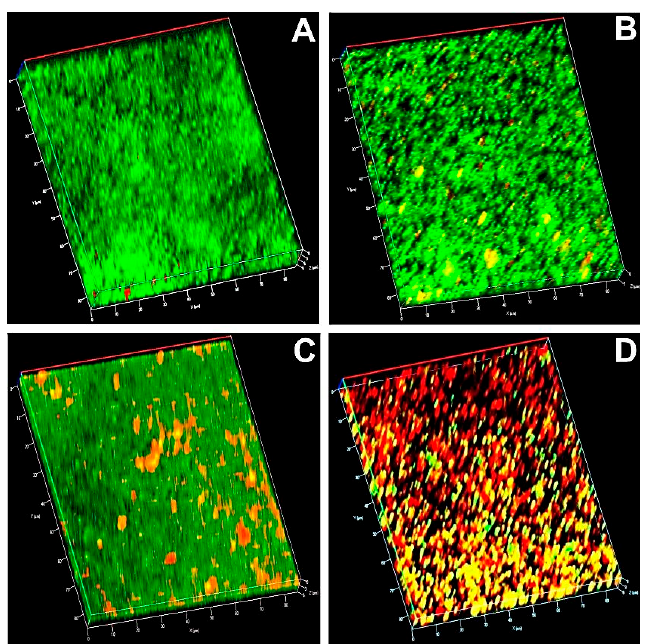
Figure 6. Confocal laser scanning microscopic image of S. aureus ( A ) irradiated biofilm (control); ( B ) biofilm treated with MB and irradiated; ( C ) biofilm treated with AgNPs and irradiated; ( D ) biofilm treated with MB-AgNPs and irradiated. Green represents live cells; Red represents dead cells in the biofilm.